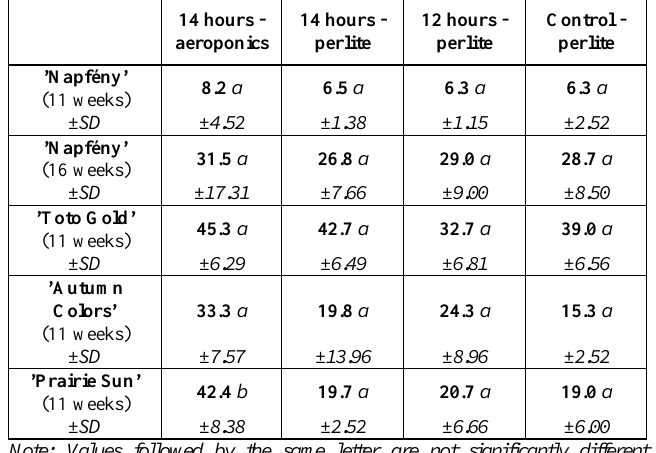
Table 2. Number of leaves of 11 and 16 weeks Rudbeckia hirta L. plantlets depending on photoperiodic lighting treatments and media (University of Debrecen, Biological Research and Plant Experiment Greenhouse - Biodrome, Debrecen, Hungary, 2021).